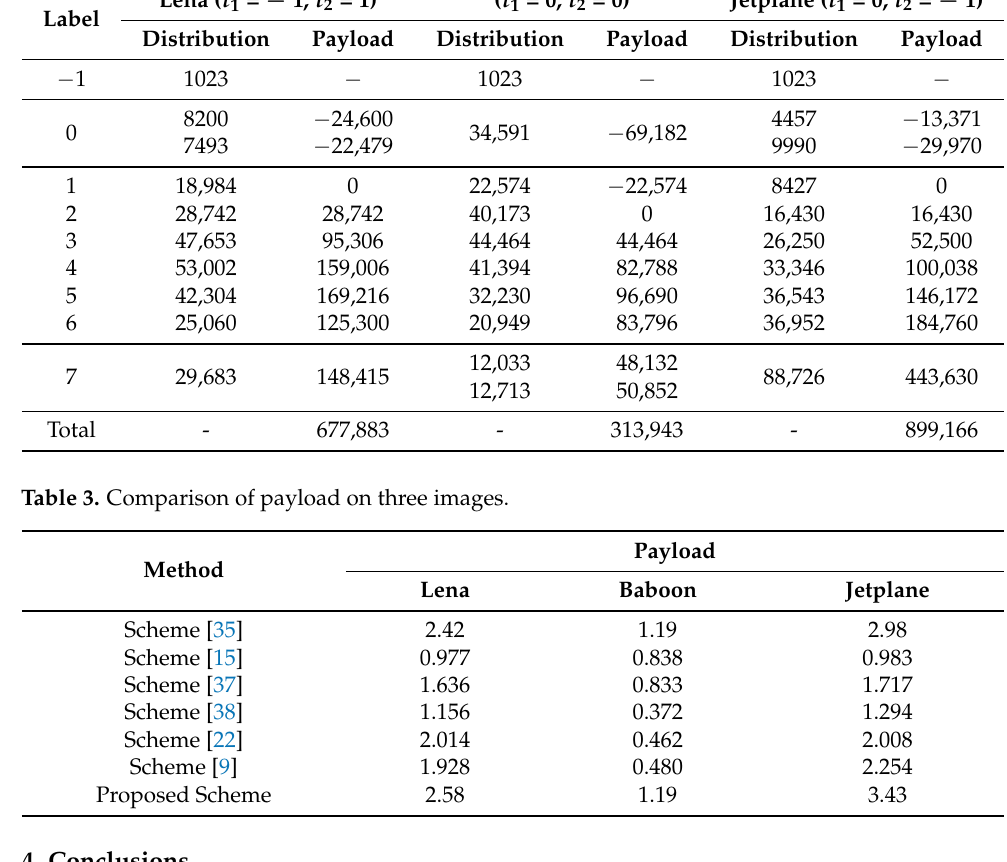
Table 2. The pure payloads of images “Lena”, “Baboon” and “Jetplane”. Label